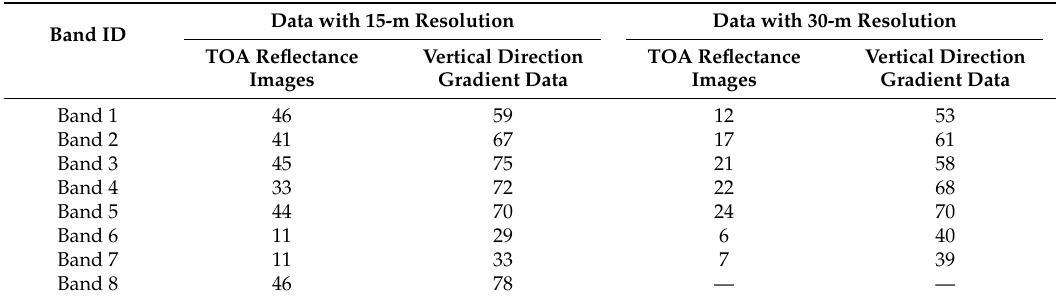
Table 8. Numbers of detected tidal cracks with lengths greater than 500 m generated by matching detected lines with manual interpretation results and detected lines.